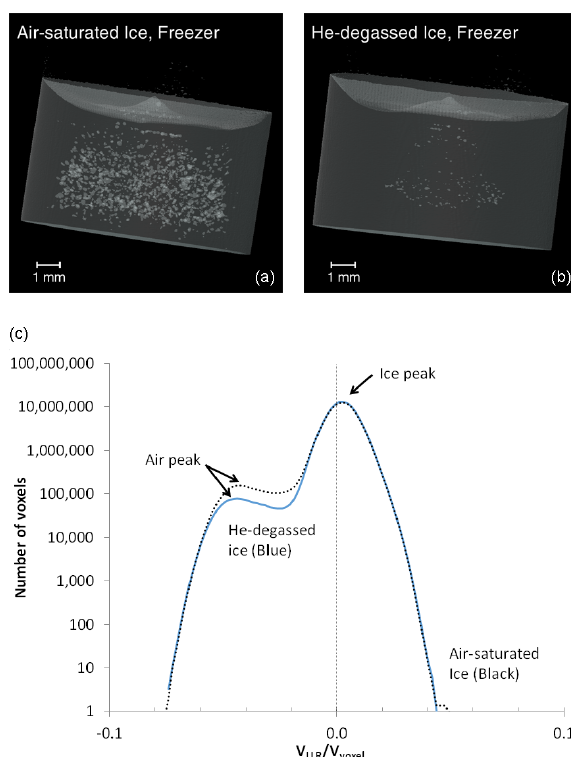
Figure 2. Reconstructed images (a, b) and histogram (c) of water ice samples frozen in a laboratory freezer, imaged using microCT ( ∼ 16µm voxel size) and segmented to show air bubbles (light gray) and the bulk ice matrix (darker gray). The glass sample vial is not shown. The ice in panel (a) was made using air-saturated water, while that in panel (b) was made with water degassed with helium for 30 min before freezing. Panel (c) shows the distributions of the radiodensities within the two samples, expressed as the fraction of each voxel that would be occupied by a liquid-like region (LLR) assuming the total solute concentration is determined by freezing- point depression (i.e., 5.4M at − 10 ◦ C; Cho et al.,